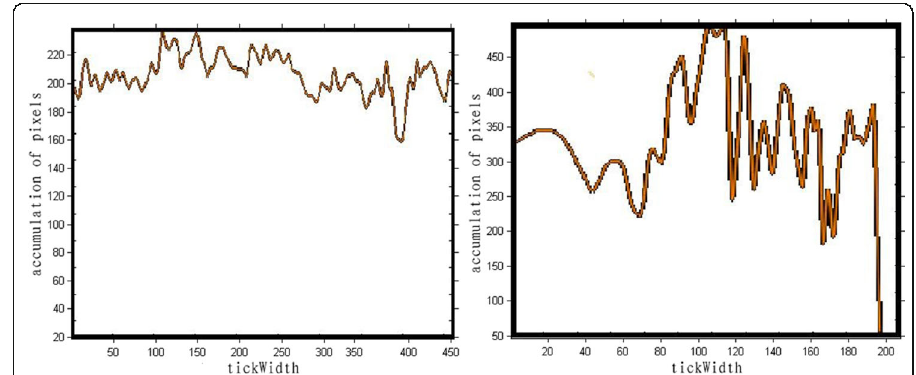
Fig. 6 Example of integration projection based on images with super refraction